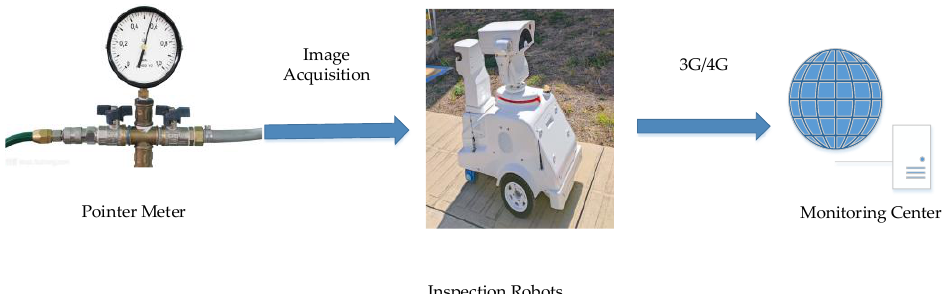
Figure 1. Automatic reading based on machine vision.